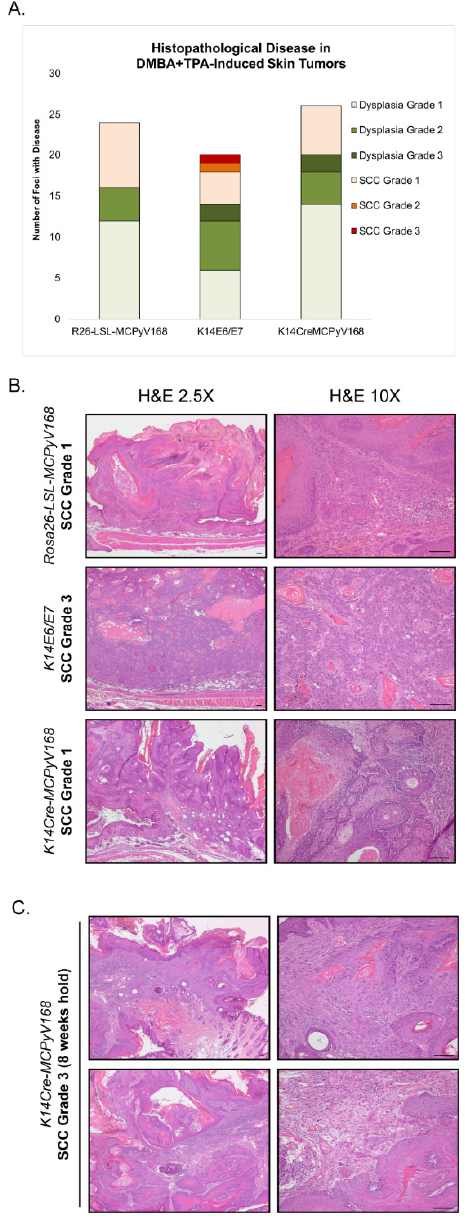
Figure 3. Assessment of malignant progression. ( A ) After the 20 week DMBA+TPA treatment period, tumor-bearing Rosa26-LSL-MCPyV168 , K14E6/E , and K14Cre-MCPyV168 mice were held without further treatment for an additional 5 weeks. Skin was harvested, sectioned into 5 µ M sections and placed on glass slides, and stained with hematoxylin and eosin (H&E). Tissues were evaluated for histopathological disease. Each foci/tumor evaluated was given a score for worst disease among the following grades: Dysplasia Grade 1, Dysplasia Grade 2, Dysplasia Grade 3, Squamous Cell Carcinoma (SCC) Grade 1, SCC Grade 2, or SCC Grade 3. The number of foci with each disease score in each group of mice is indicated in the bar graph. The overall disease severity between groups was not statistically significant (two-sided Wilcoxon rank-sum test; all p -values > 0.17 for all comparisons). ( B ) Representative H&E-stained images of tissue sections from tumors harvested from DMBA+TPA-treated Rosa26-LSL-MCPyV168 , K14E6/E7 , and K14Cre-MCPyV168 mice after 5